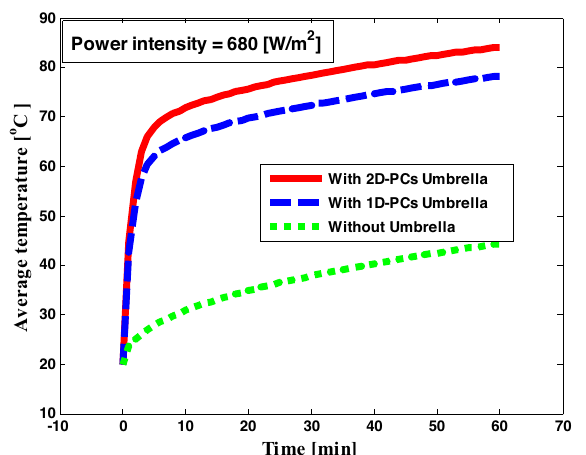
Figure 11. The average temperature versus time of the saline water sample with different shapes of solar umbrella.